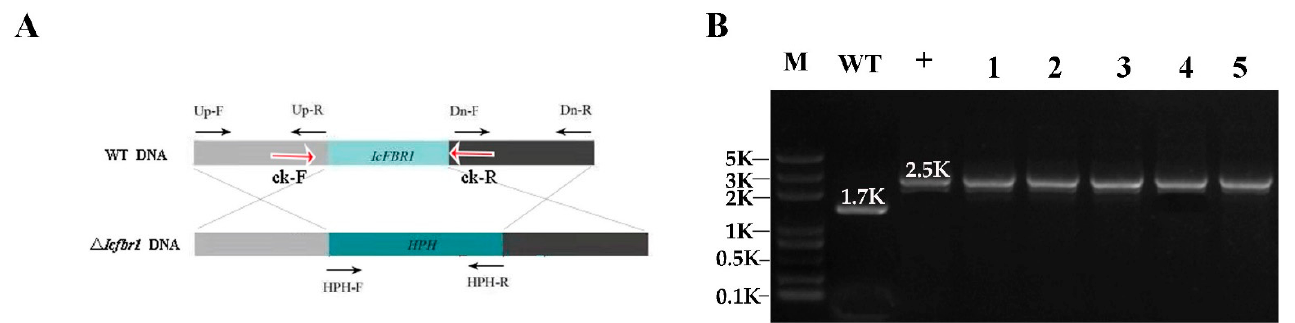
Figure 1. Identification of IcFBR1 gene in Isaria cicadae . ( A ) Schematic diagram of targeted disrup- tion of IcFBR1 via homology-dependent gene replacement. ( B ) Verification of the null mutants by PCR. M—Trans 2K DNA marker; lane WT—wild-type strain 2-2; lane +—Knockout plasmid; lane 1–5— IcFBR1 gene mutants.